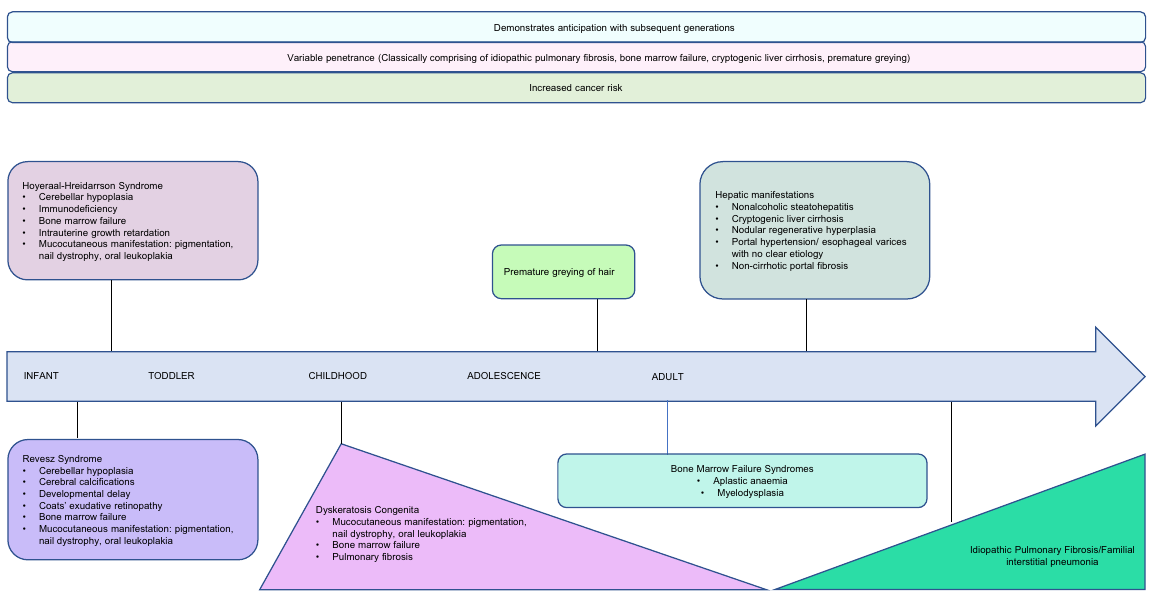
Fig. 4 The natural history of telomere biology disorders. Each disorder has its own spectrum of clinical features. Hoyeraal – Hreidarsson Syndrome and Revesz Syndrome present early in childhood and are considered more severe subtypes of dyskeratosis congenita. Dyskeratosis congenita presents commonly in childhood but may manifest at any age. Patients classically present with the mucocutaneous triad of abnormal skin pigmentation, nail dyskeratosis and leukoplakia, and bone marrow failure is the most common cause of death. Idiopathic pulmonary fi brosis is the most common presentation and typically presents after the age of 60. A constellation of premature greying, bone marrow failure, pulmonary fi brosis and cryptogenic liver cirrhosis is suggestive of telomere biology disorders, but due to incomplete penetrance and various inheritance patterns of germline mutations, not all features may be present. The disease demonstrates anticipation with earlier and more severe manifestations down the generations. Across all phenotypes and ages, patients are at an increased risk of